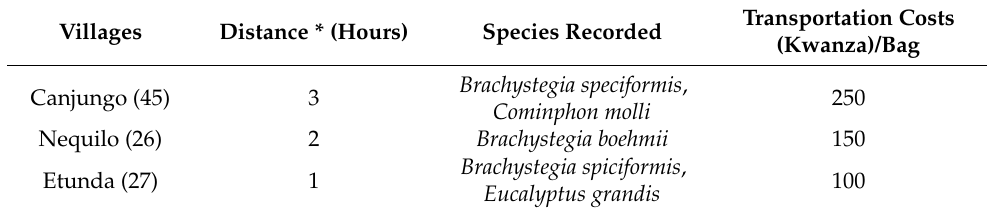
Table 3. Distance of the production sites from Kuito market and differences in transportation costs. Villages